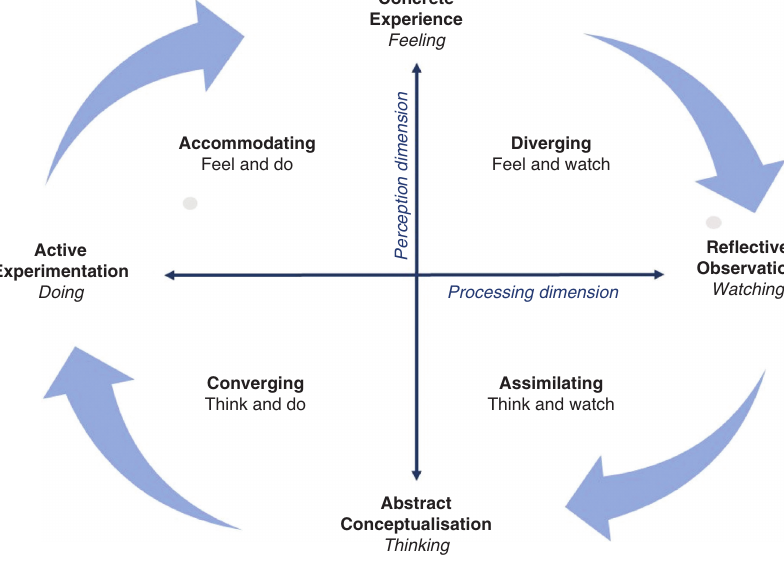
Concrete Experience